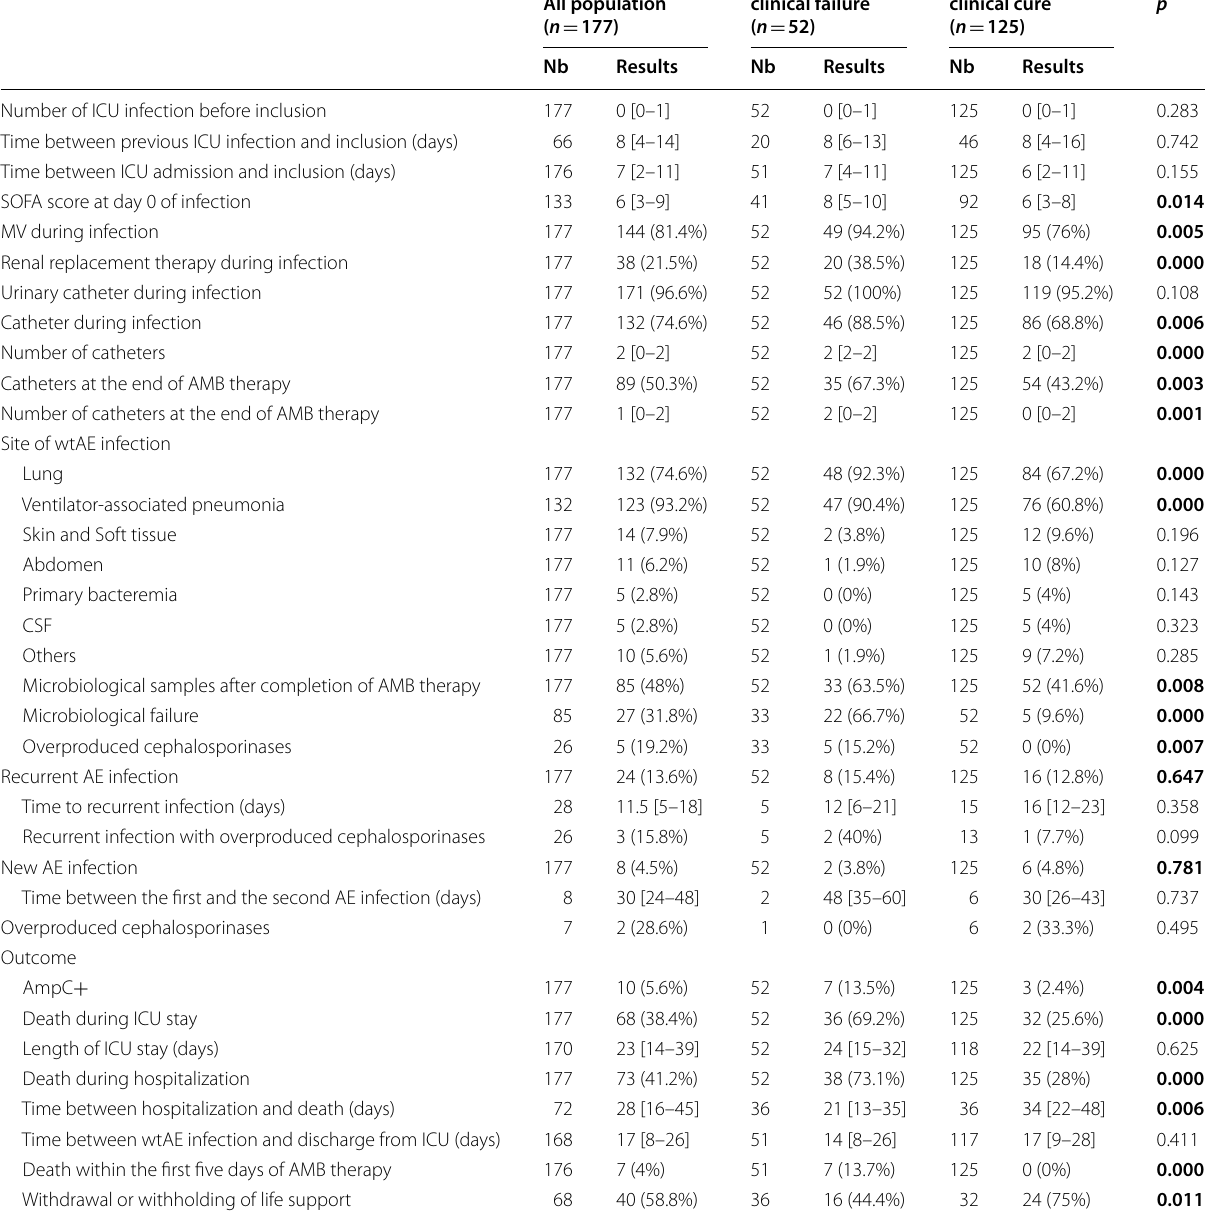
Table 3 Characteristics and outcome at inclusion (Day 1 of wild‑type AmpC‑producing Enterobacterales